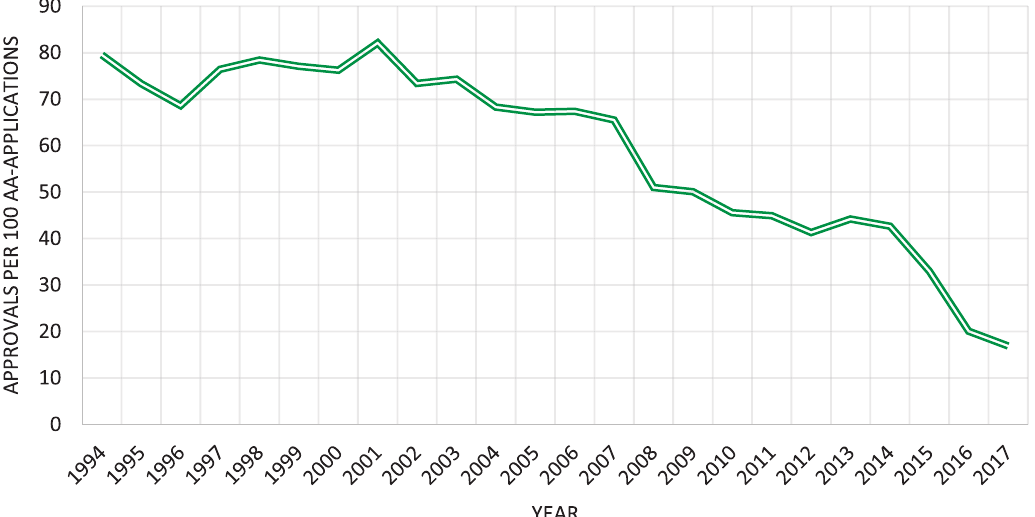
Figure 2. Approval rate for first-time AA-applications, 1994–2017. Sources: SSIA (2017a); data from SSIA retrieved from Independent Living Institute